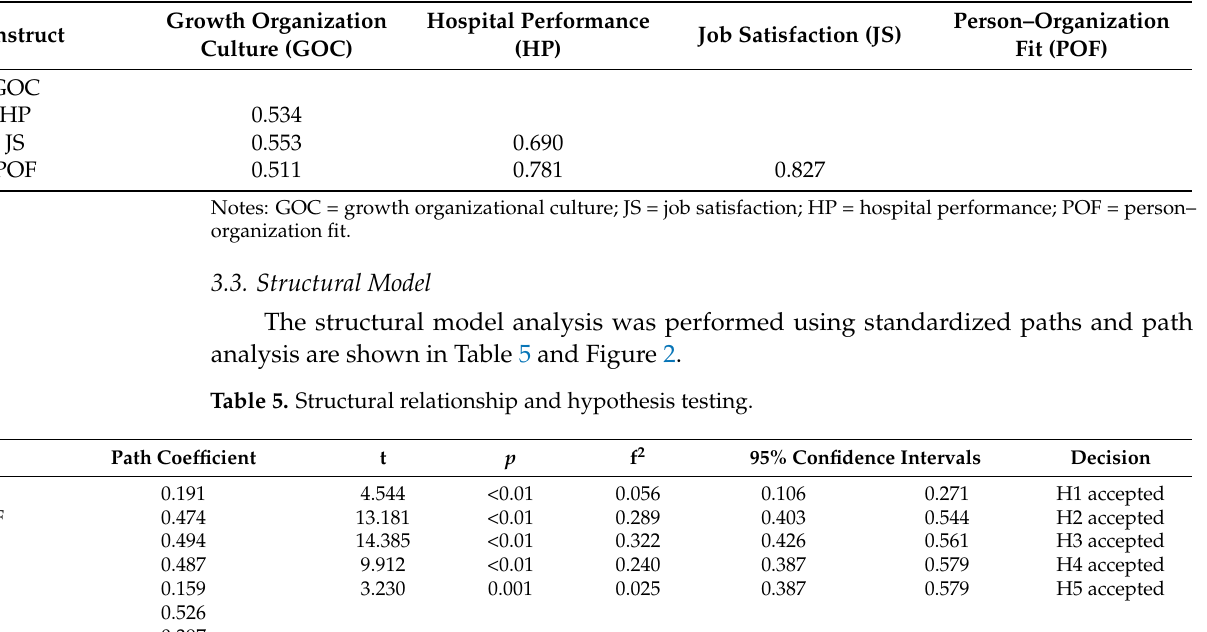
Table 4. Discriminant validity of heterotrait/monotrait ratio (HTMT).